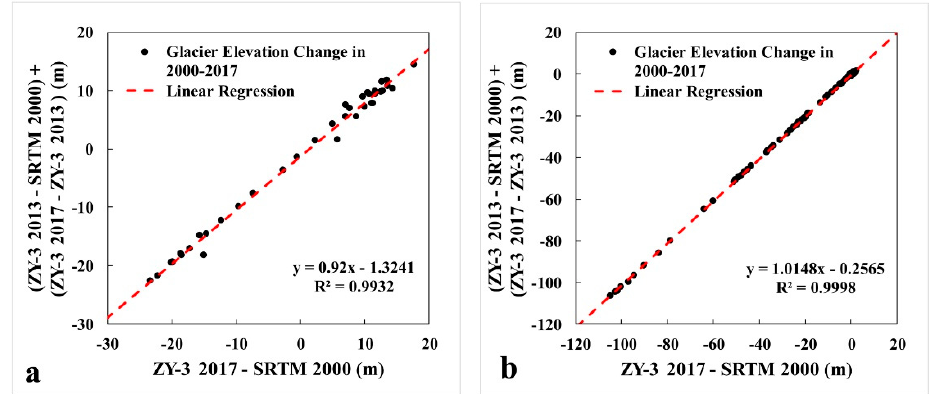
Figure 14. Cross-validation of the glacier elevation changes generated by the two methods in the WNM ( a ) and ENM ( b ).